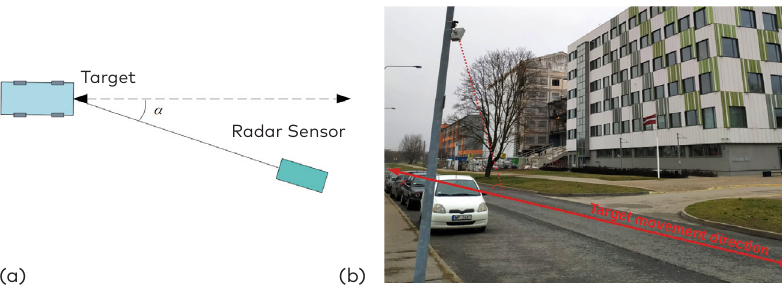
Figure 17. Influence of the radar towards moving object position on the measured speed: (a) schematically (K-LD2); (b) position of the